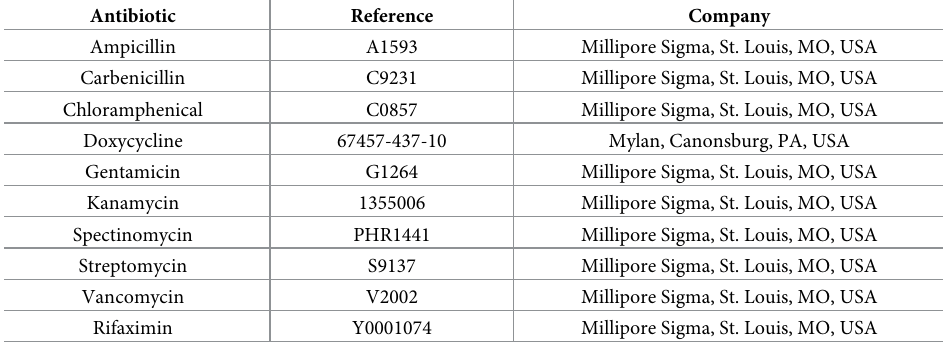
Table 6. Antibiotics used in this